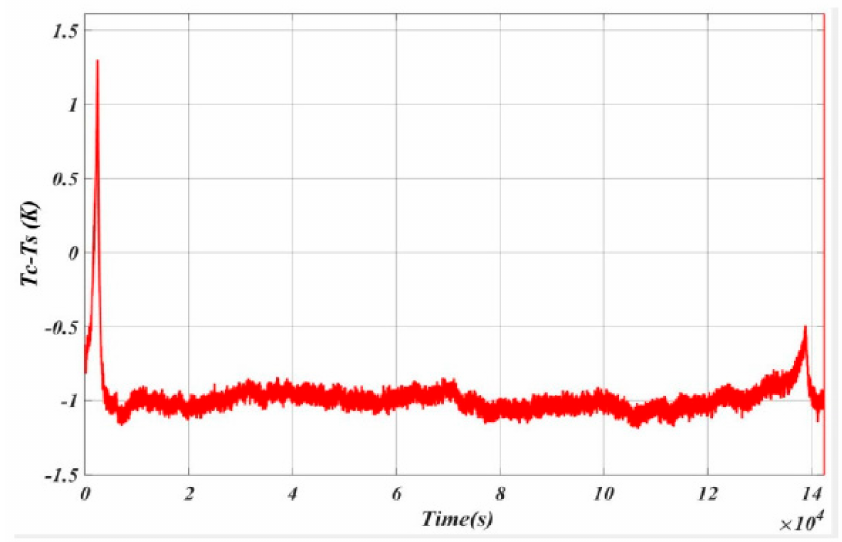
Figure 18. Difference between T c and T s obtained from the second-order thermal model.